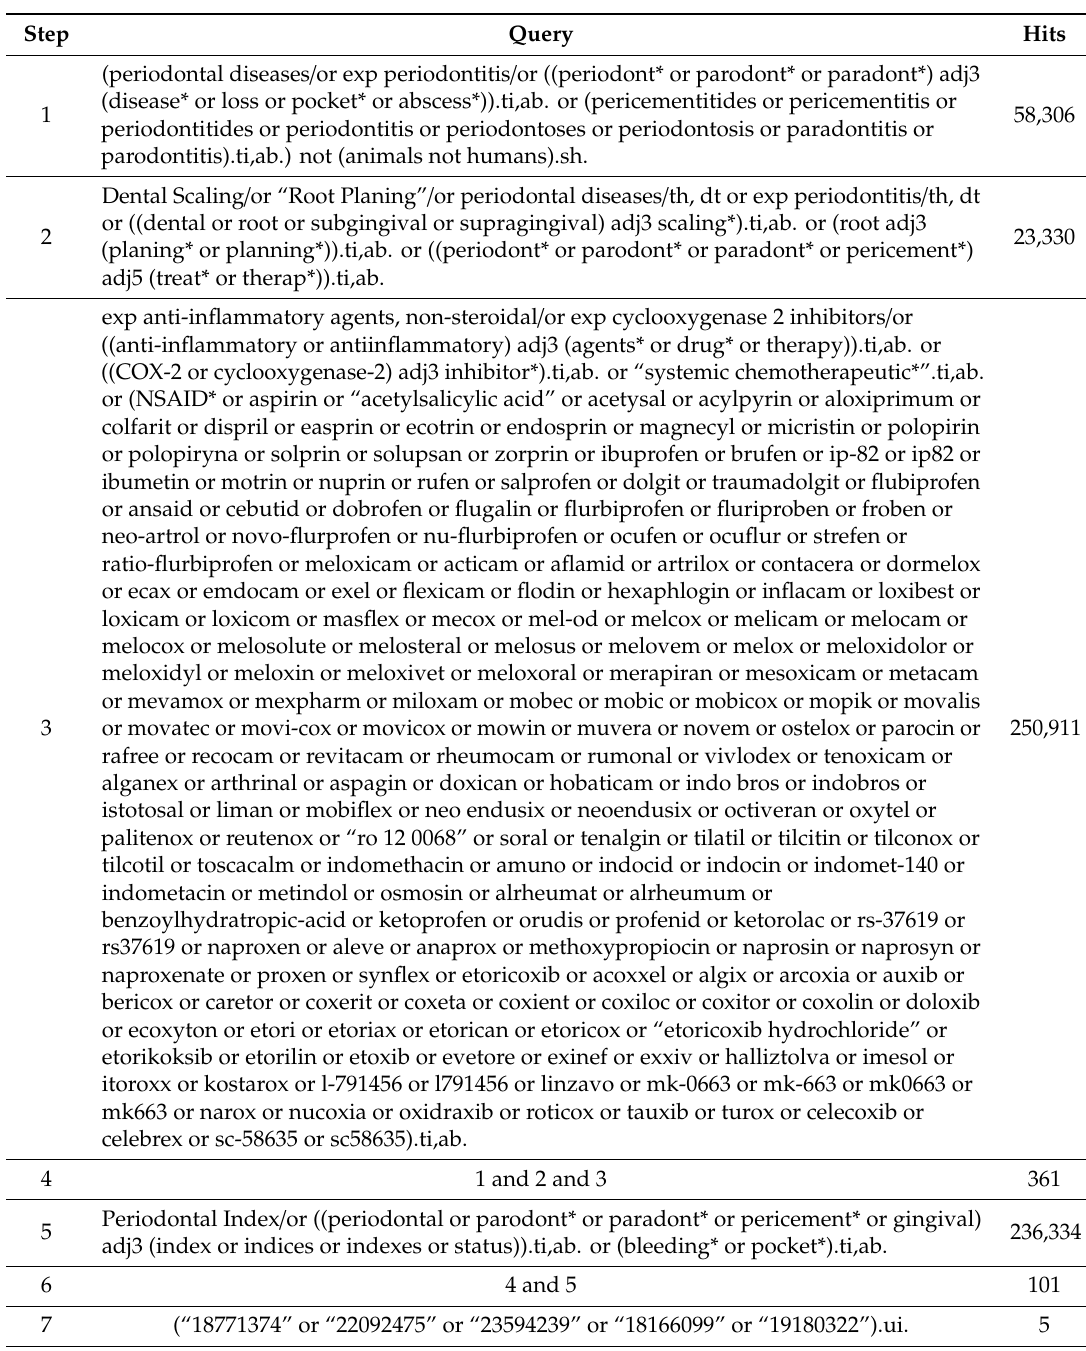
Table A1. Pubmed Search